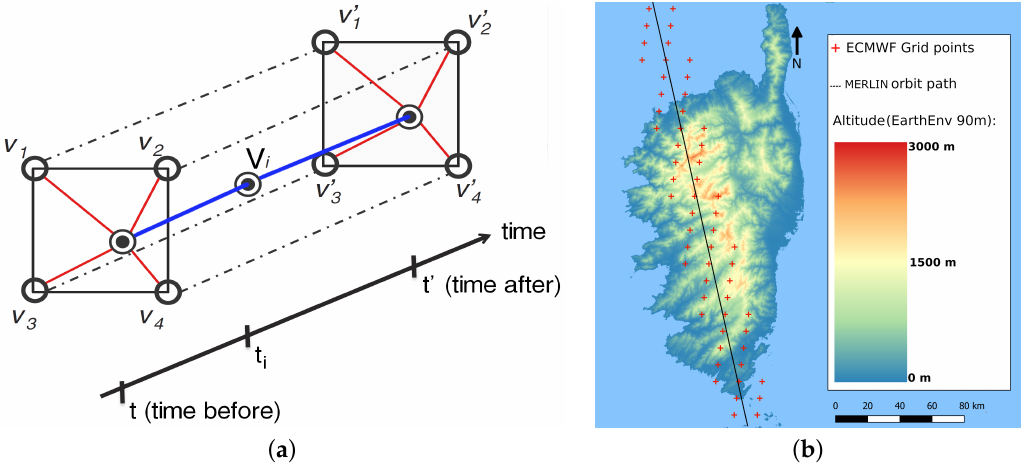
Figure 1. ( a ) Schematic of time and horizontal interpolations. An observation is made at time t i between times t and t (cid:48) corresponding to the times when meteorological data are available. V 1 , V 2 , V 3 , V 4 are the value of a parameter at four points around the target point at time t and V (cid:48) V (cid:48) are the value at the same points at time t (cid:48) . V i is the interpolated value at the target point at time 4 t i . ( b ) For the Corsica region, on a representation of the topography from the EarthEnv DEM [15], the points where meteorological data are available in the ECMWF database are in red and the target points that are part of the MERLIN ground track are in